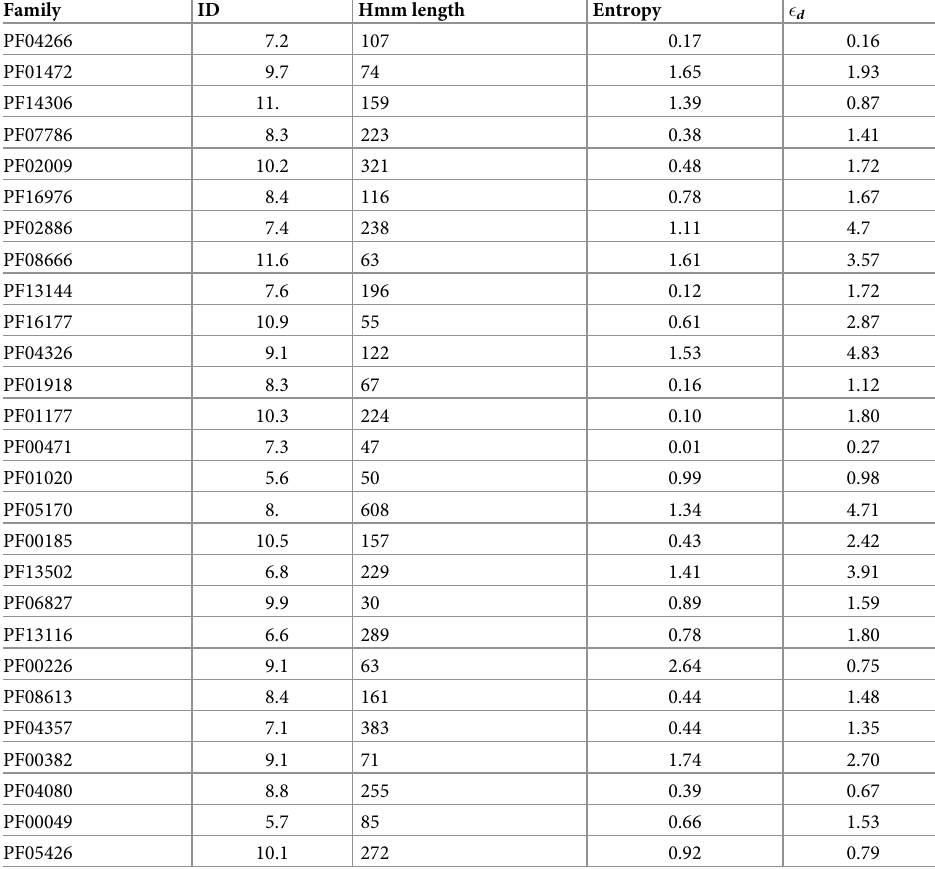
Table 1. Intrinsic dimension, lenght of the seed alignment, architecture entropy and error on the ID measure � d for 27 Pfam familes in Pfam notation. Family ID Hmm